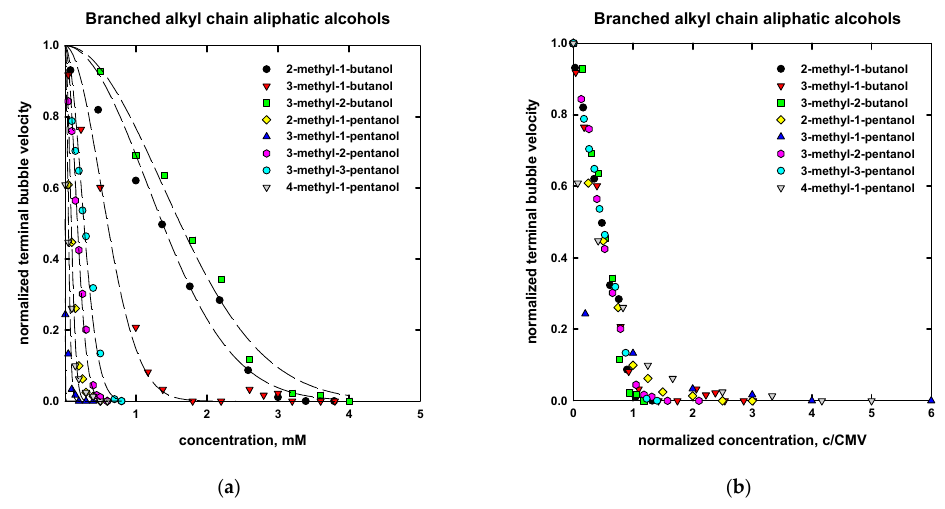
Figure 6. Influence of branched alkyl chain aliphatic alcohols concentration expressed in mM ( a ) and normalized surfactant concentration ( c /CMV) ( b ) on the normalized terminal bubble velocity.